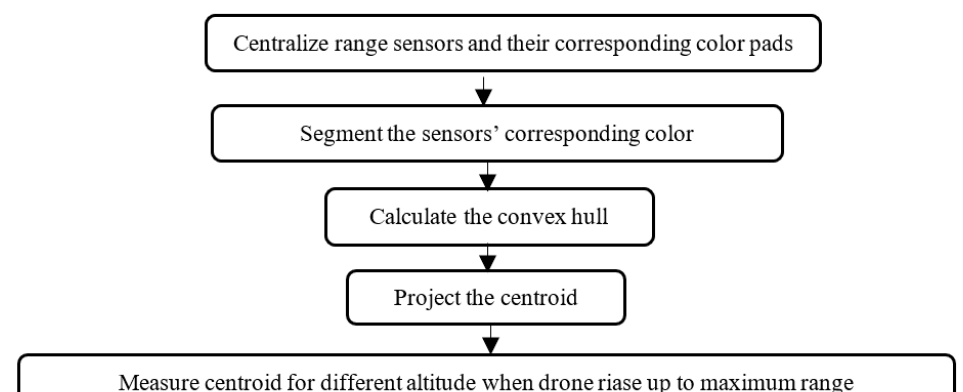
Figure 3. Cartesian coordinates of the landing platform and the designated drone.